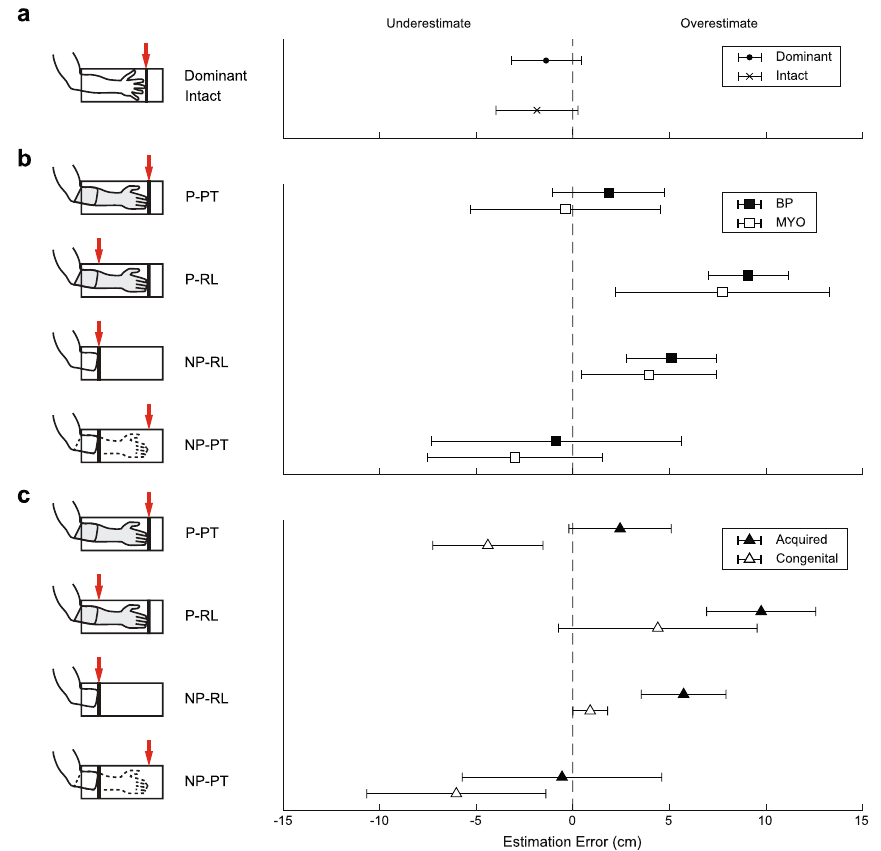
Figure 3. Limb length estimation error. ( a ) Average limb length estimation for the dominant (‘o’) limbs of controls, as well as the intact limbs for all prosthesis users (‘x’). ( b ) Average limb length estimation error for BP (solid squares) and MYO (open squares) prosthesis users. ( c ) Average limb length estimation error for participants with acquired limb loss (solid triangles) and congenital (open triangles) limb absence. Error bars represent standard deviation across subjects.